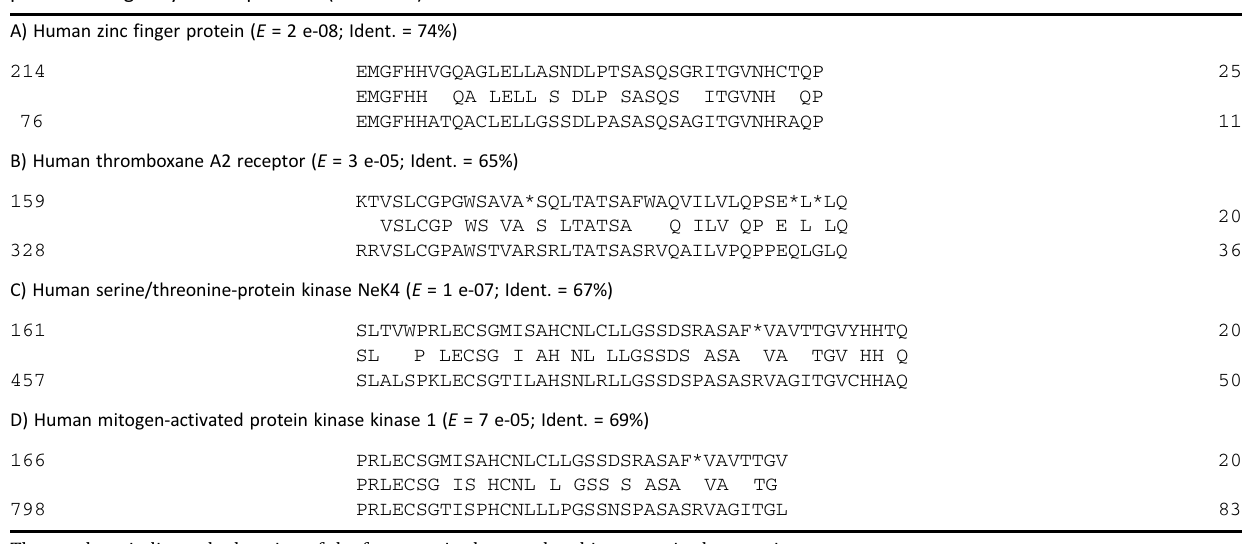
Table 1. Comparison of translated human lysozyme intron 1, 5 ′ 3 ′ frame 1 (A and B) and frame 3 (C and D) fragments (first line) with part of biologically active proteins (third line).